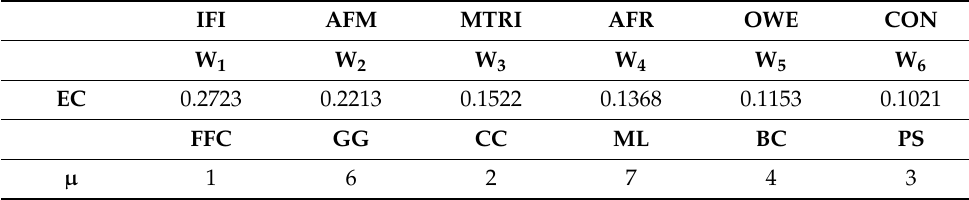
Table 7. Weighting vectors and induced values for credit.